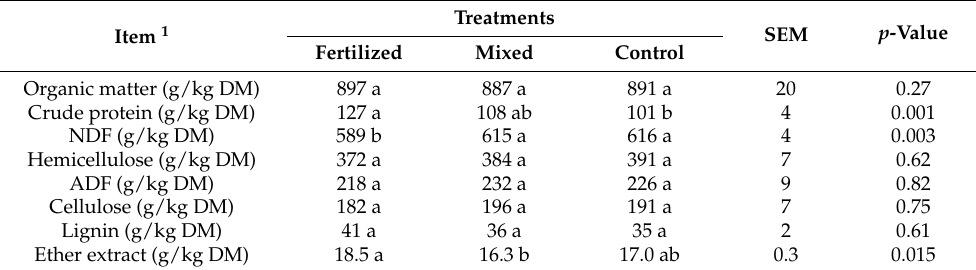
Table 2. Chemical composition of palisade grass fertilized with urea (150 kg N/ha/year), mixed with pintoi peanut (mixed), and without N fertilization (control). Average of 2 years of evaluation of 5 grazing cycles ( n = 40).